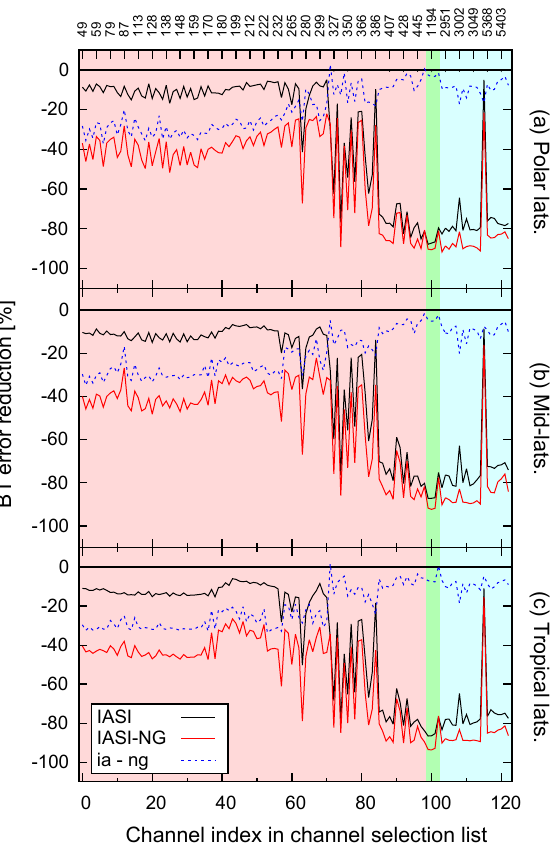
Figure 9. Error reduction ( σ reduction ) in percentage for IASI obser- vations in brightness temperature units for polar regions (a) , mid- latitudes (b) and tropics (c) . Black and red curves present the error reductions for IASI and IASI-NG respectively, whereas the blue line represents the differences between the two instruments. Coloured boxes correspond to the sensitivity of the channels (red: tempera- ture; green: window; blue: water